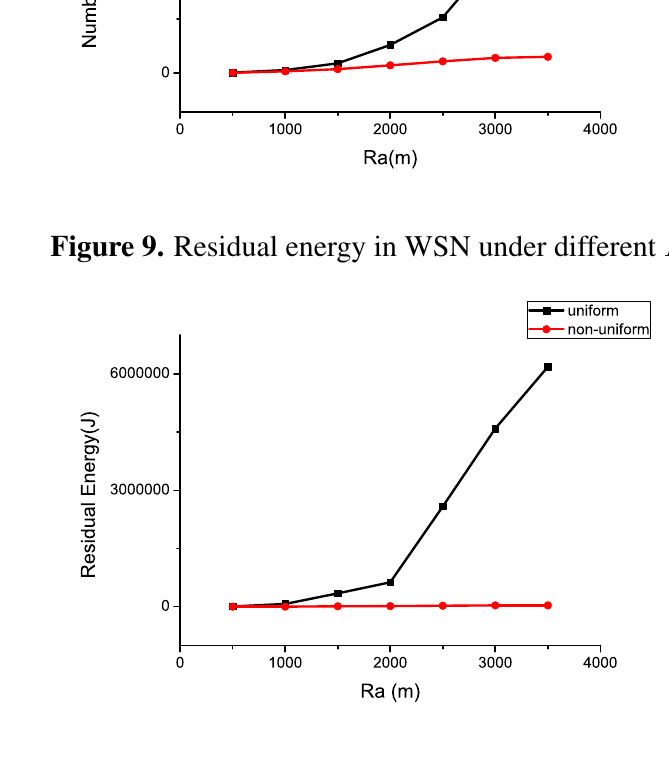
Figure 9. Residual energy in WSN under different R